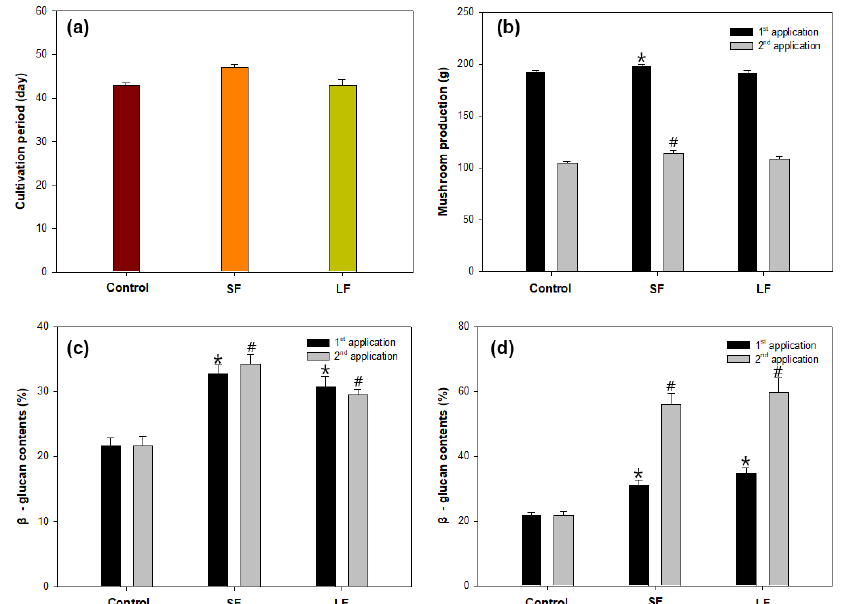
Figure 3. Elicitation of Sparassis latifolia by alginate oligosaccharide fractions on ( a ) cultivation period, ( b ) mushroom production, ( c ) β -glucan content of the fruiting body, and ( d ) β -glucan content of the stalk. SF: Solid fraction of Sargassum fusiforme ; LF: Liquid fraction of S. horneri ; Control: distilled water. (All data are presented as the mean ± SD. A t -test was used to compare the control and treated samples. * p < 0.05, vs. the control in first application; # p < 0.05, vs. the control in second application).